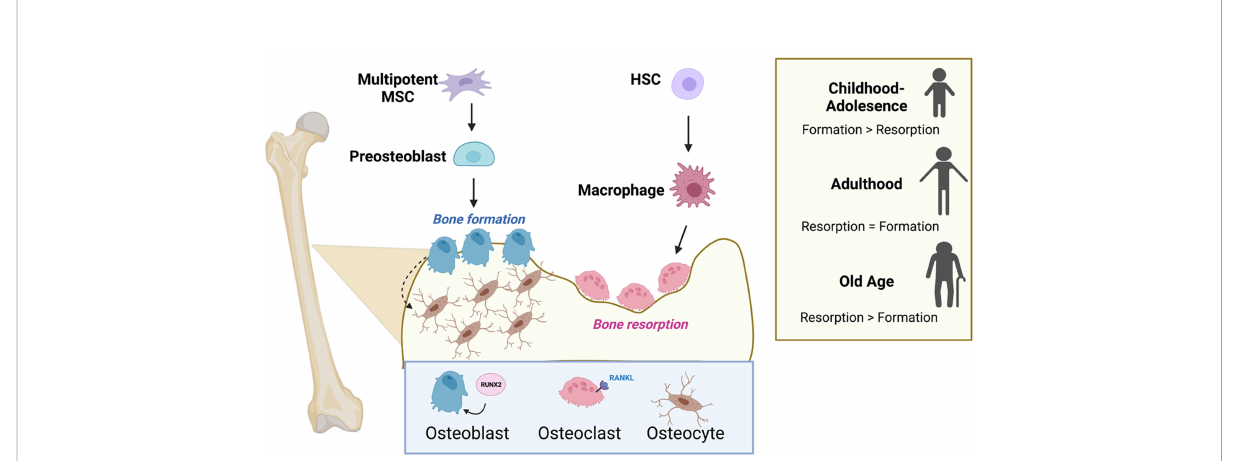
FIGURE 2 Osteoblasts, osteoclasts, and the cycle of bone remodeling. Bone remodeling balances the competing actions of the bone-building osteoblasts and the osteoclasts that promote bone resorption. Osteoblasts and osteocytes originate from common precursor bone marrow mesenchymal stem cells (MSCs), while osteoclasts are multinucleated and originate from hematopoietic stem cells (HSCs) in the bone marrow. Successful differentiation of progenitor cells into osteoblasts and osteoclasts requires the transcription factor, RUNX2 and RANK-ligand (RANKL), respectively. The level of bone formation versus bone resorption is dynamic and changes with age. Formation exceeds resorption during adolescence, and the scale tips the opposite direction favoring resorption in old age. Figure was created with